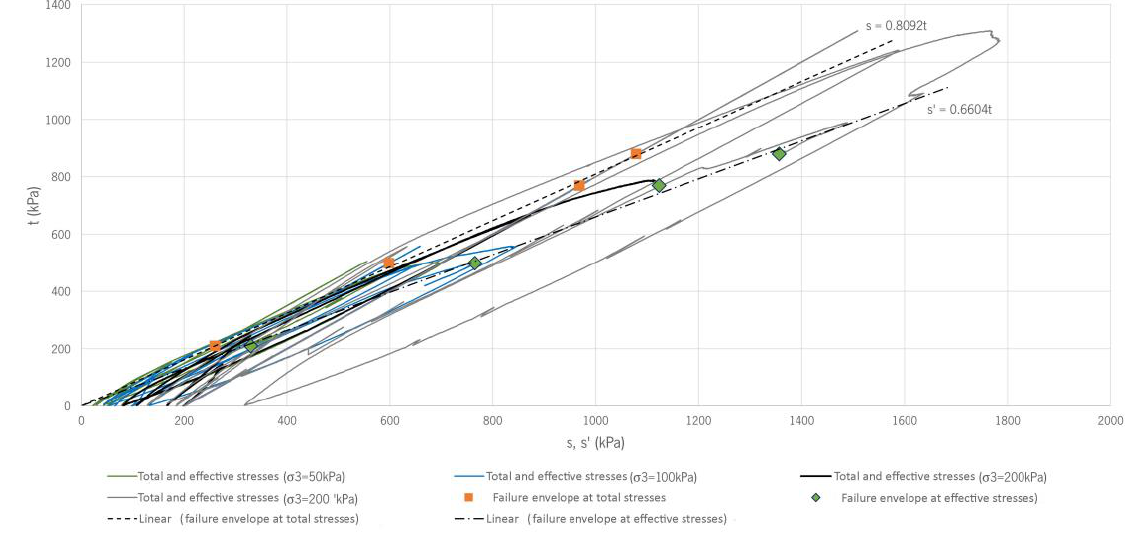
Figure 21. Failure envelopes of the mine tailing in residual deviatoric stresses (stabilized specimens). Table 7. Shear strength parameters of the mine tailing before and after stabilization (residual devia- toric